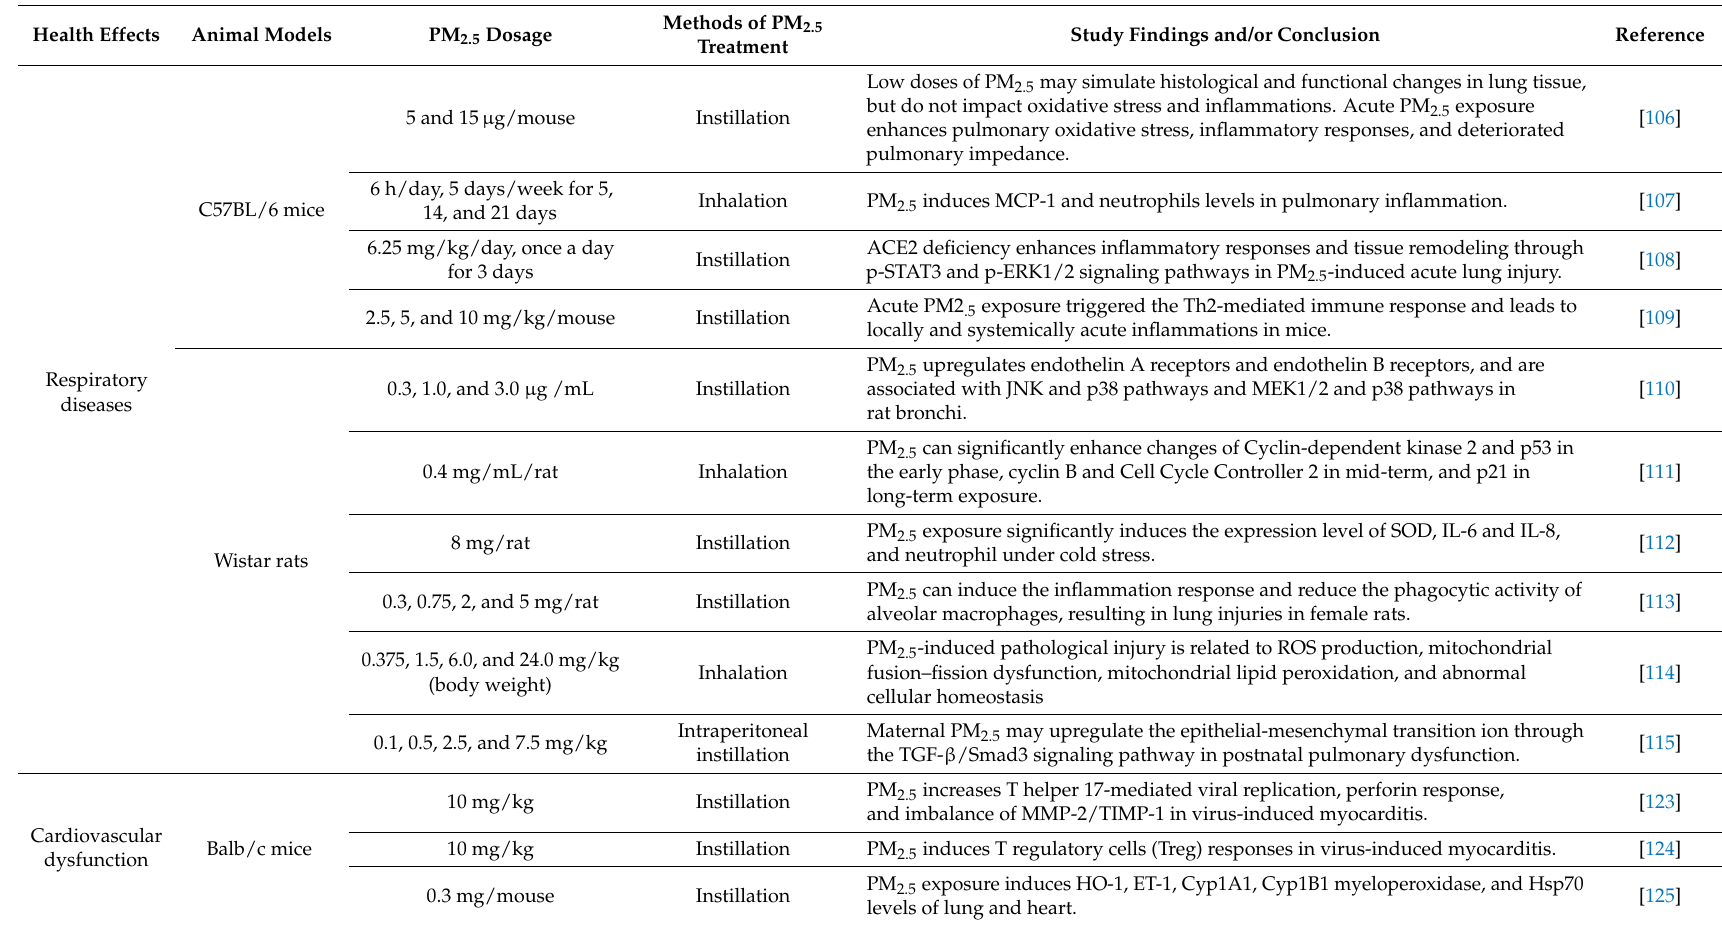
Table 2. Summary of in vivo studies on health effects of PM 2.5